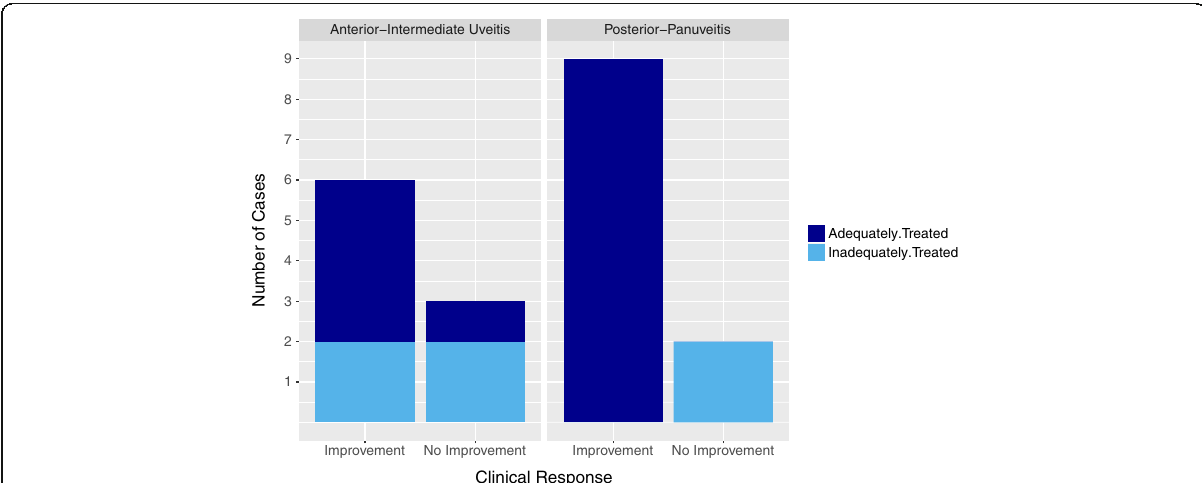
Fig. 1 Clinical improvement stratified by initial uveitis presentation and adequate or inadequate ATT for active TB. Numbers presented as